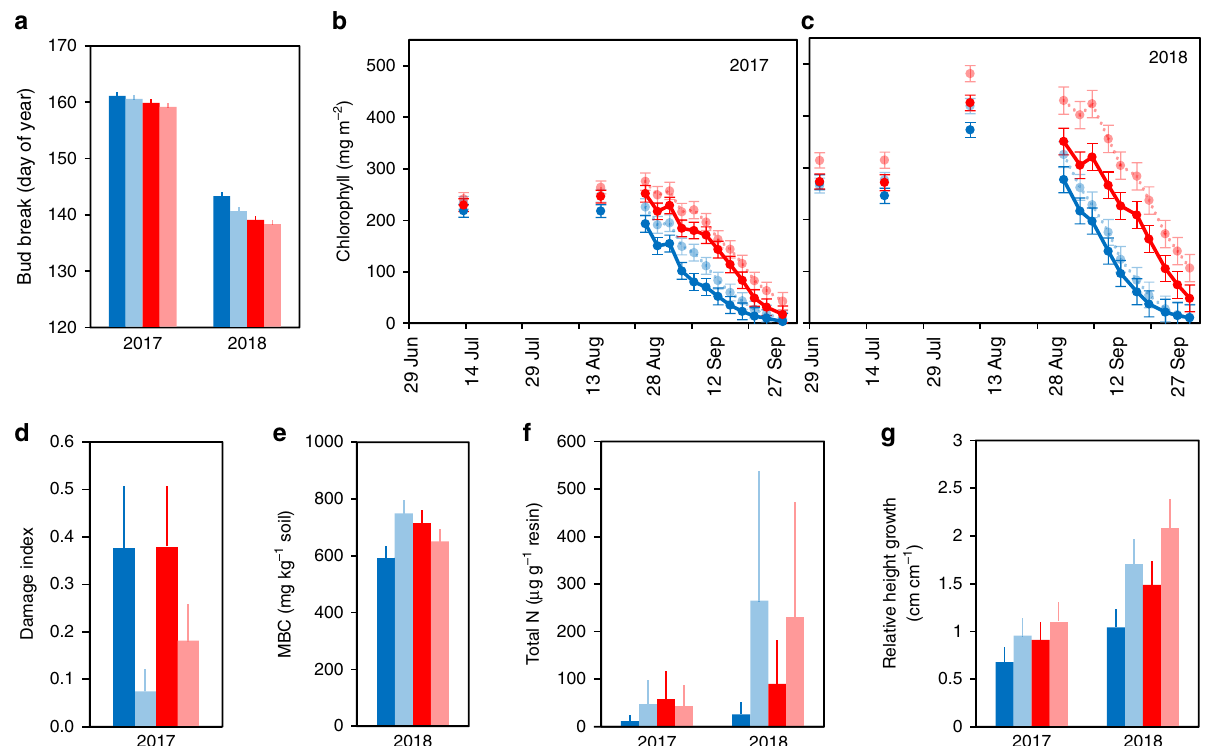
Fig. 2 Longer growing seasons and enhanced soil mineral N explain better plant growth under warming and reduced herbivory. Birch plantlets had a earlier spring bud break (Supplementary Table 3; for each mean n = 57 – 60 plantlets growing in 5 replicate fi eld plots) and b , c higher leaf chlorophyll content in summer and autumn (Supplementary Table 4; for each dot in 2017 n = 57 – 60 and for each dot in 2018 n = 39 – 60 plantlets growing in 5 replicate fi eld plots) in plots with warming (red symbols) and reduced herbivory (light tone symbols), compared to plots with ambient temperature (blue symbols) and natural herbivory (dark tone symbols), which responses together resulted in longer growing seasons. As warming did not increase d leaf herbivore damage (Table 1; for each mean n = 57 – 60 plantlets growing in 5 replicate fi eld plots), these effects together with greater e soil microbial biomass carbon, MBC (Supplementary Table 5; n = 5 fi eld plots, each examined at 3 depths of soil) and f resin bag mineral N (NH 4 + and NO 3 − ) capture (Supplementary Table 5; n = 5 fi eld plots) under warming and reduced herbivory, apparently explain the increased g relative growth of birch plantlets (Supplementary Table 3; for each mean n = 57 – 60 plantlets growing in 5 replicate fi eld plots) under these treatments, which in turn likely explains the patterns observed in the CO 2 exchange of the entire fi eld layer vegetation (Table 2 and Fig. 1). All means are estimated marginal means (±s.e.m.) produced by the fi tted statistical models in Table 1 and Supplementary Tables 3 – 5. Means and errors for MBC were back-transformed from square root-transformed data and those for leaf damage index, plant growth, and total soil mineral N from log-transformed data. Source data are provided as a Source Data fi